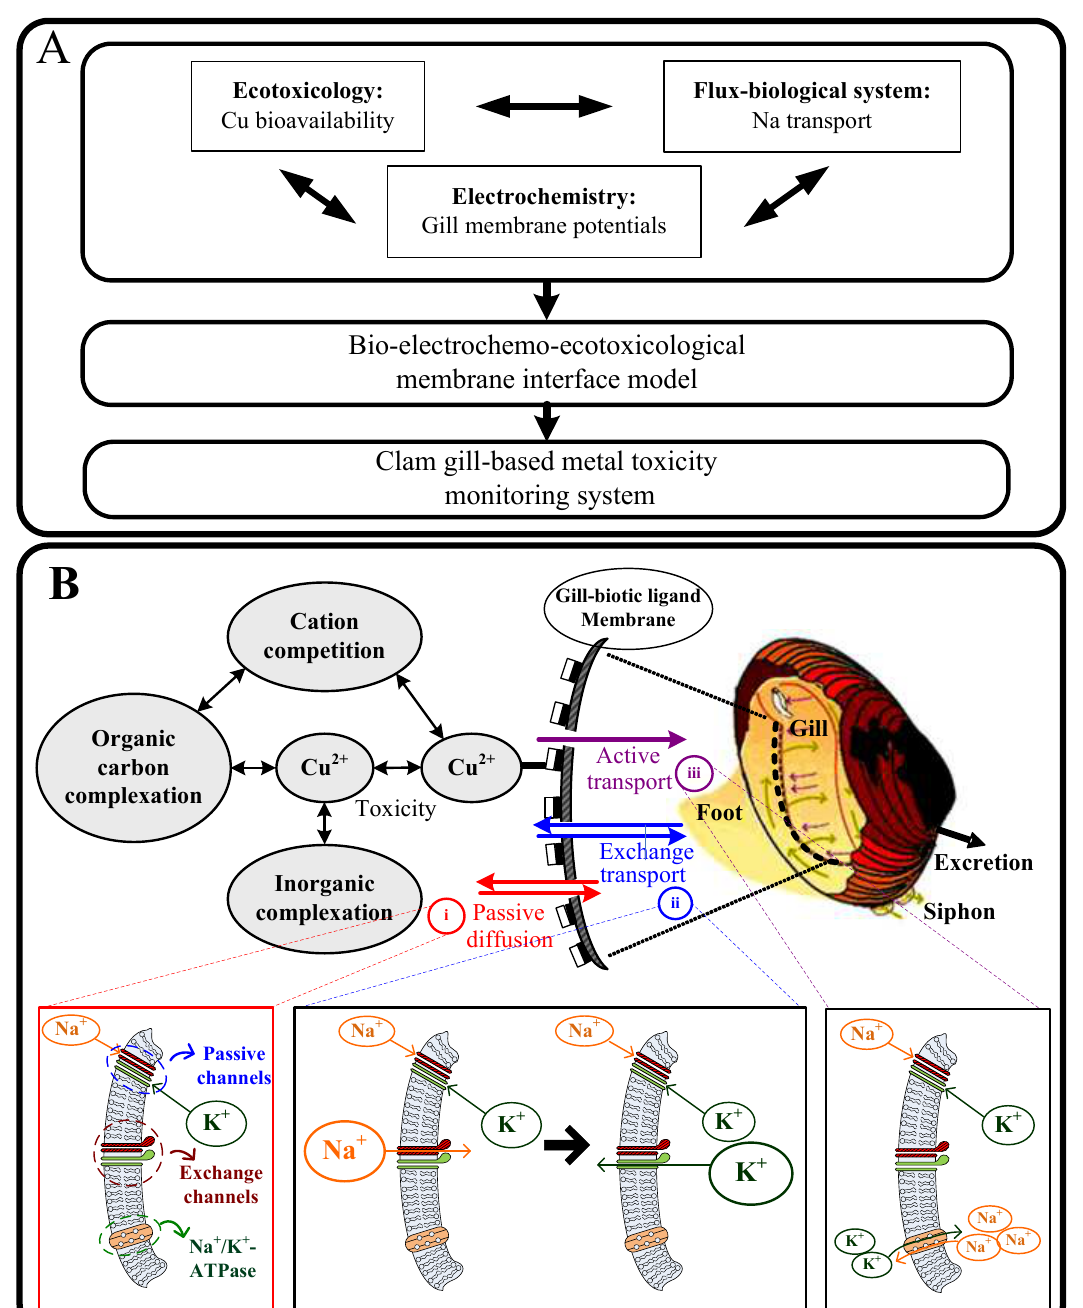
Figure 1. (A) Schematic of our proposed framework inspired from key concepts of ecotoxicology, biological physiology, and electrochemistry to derive a clam gill-based membrane interface model for the future design of environmental biomonitoring and prediction of metal toxicity. (B) BLM-based Cu bioavailability associated with the affinity and capacity of gill to bind copper based on site-specific water quality parameters in that physiological mechanisms of Na transport in gill-biotic ligand membrane including ( i ) passive diffusion, ( ii ) exchange transport, and ( iii ) active